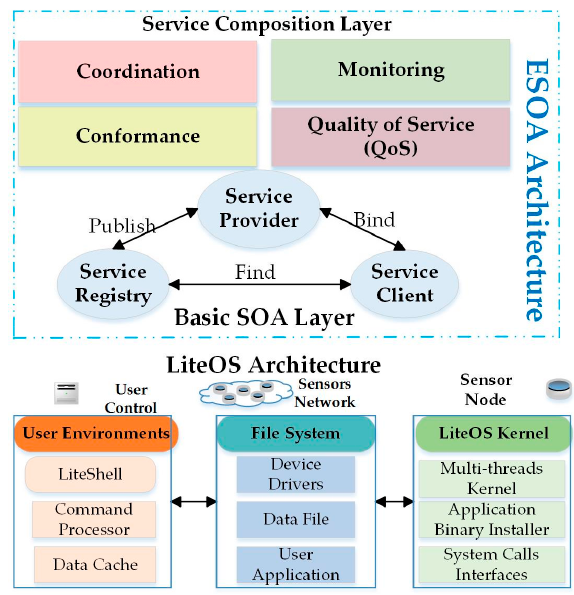
Figure 9. ESOA Architecture [54].